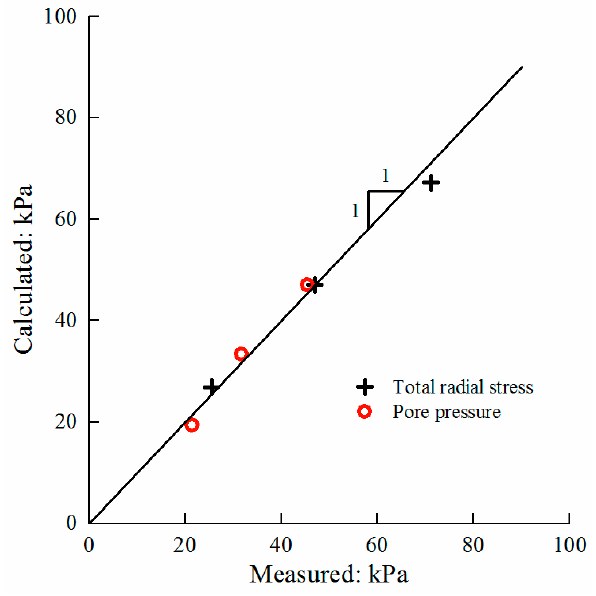
Figure 16. Calculated against measured total radial stress and pore pressure during the casing